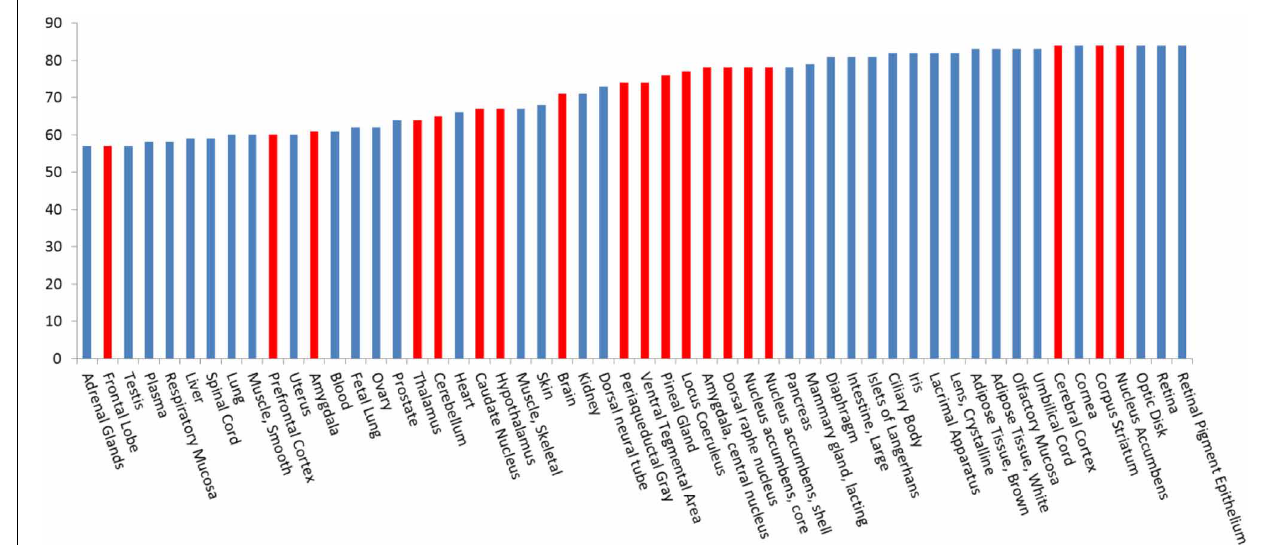
FIGURE 2 | Tissue distribution of 85 drug-abuse related GPCRs. Red lines indicate that these tissues are located in the central nervous system (CNS). For example, 84 of these 85 GPCRs are expressed in the nucleus accumbens, where most drugs of abuse